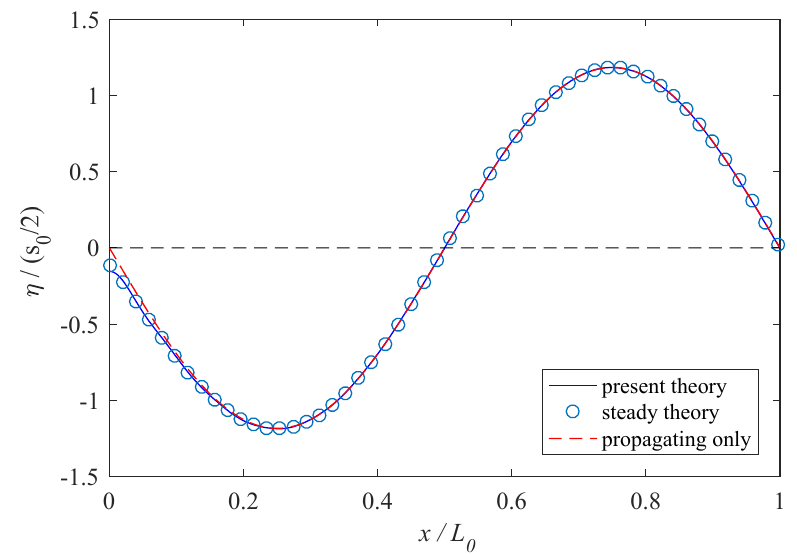
Figure 5. The first wave form in front of the wavemaker boundary.